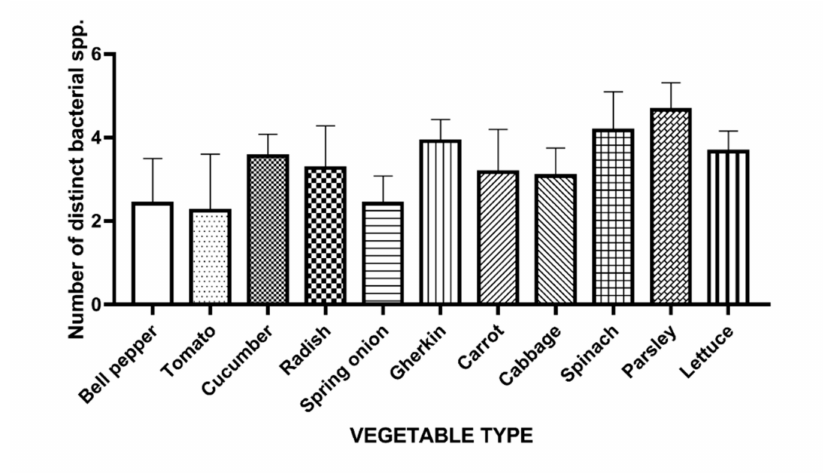
Figure 1. Average number of morphologically distinct Gram-negative bacterial species isolated from each vegetable type.